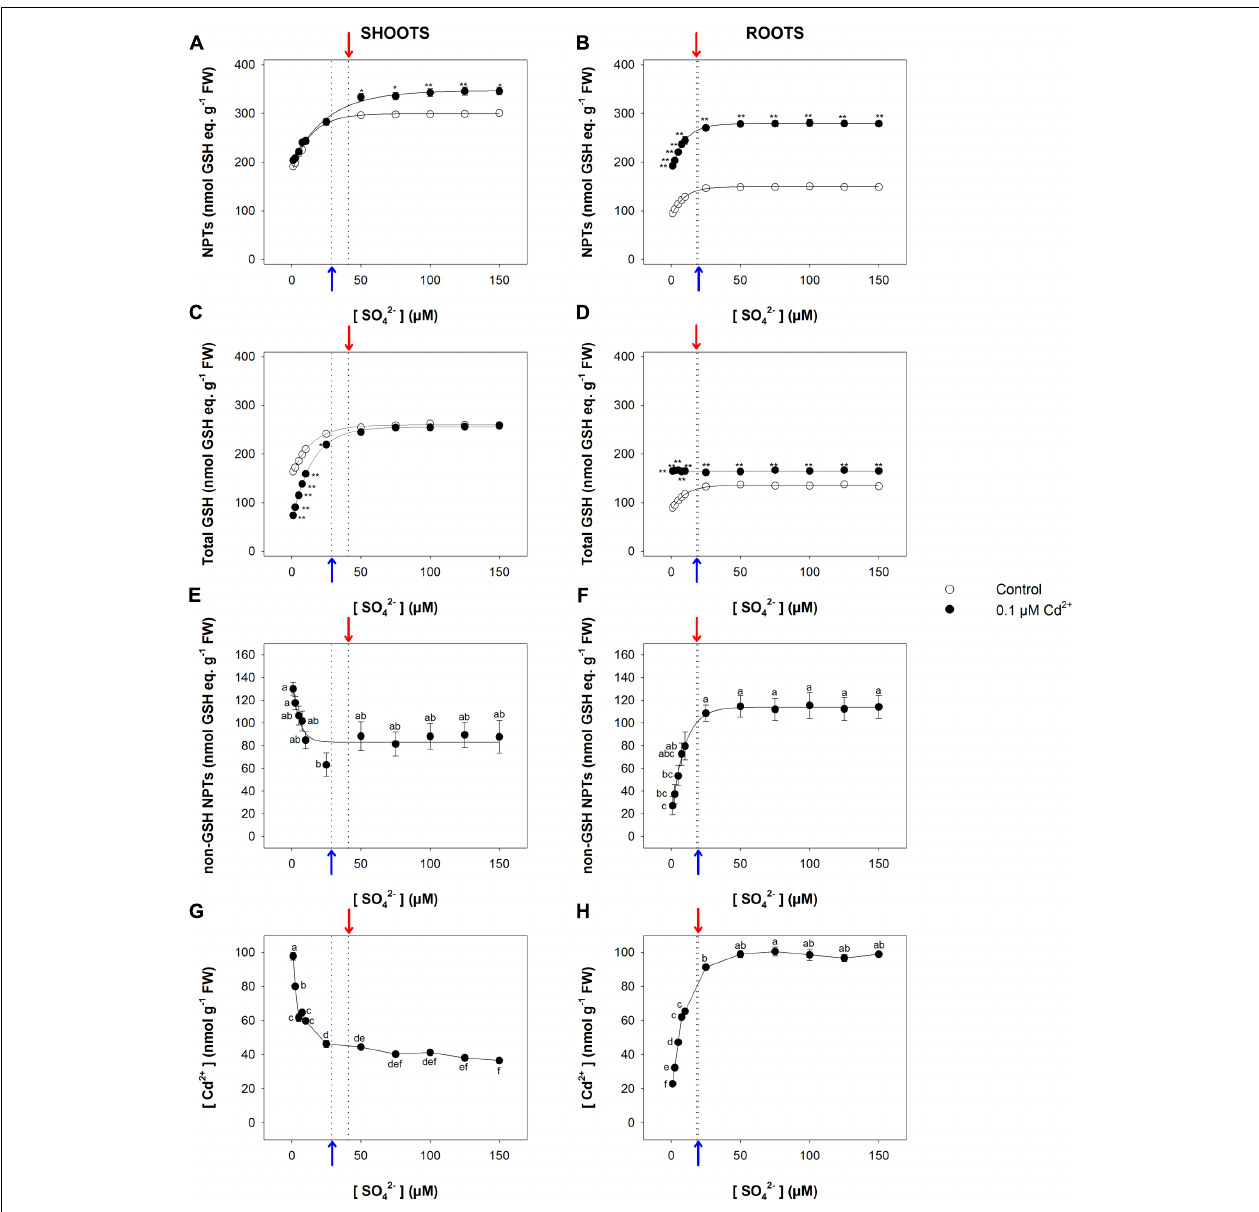
FIGURE 5 | Effect of long-term exposure to Cd on thiol and Cd levels in shoots and roots. Arabidopsis plants were grown for 22 days under a wide range of sulfate concentrations (1, 2.5, 5, 7.5, 10, 25, 50, 75, 100, 125, and 150 µ M) in the presence or absence of 0.1 µ M Cd 2 + . NPT levels in shoots (A) and roots (B) ; total GSH levels in shoot (C) and roots (D) ; PC levels in shoots (E) and roots (F) ; Cd contents in shoots (G) and roots (H) . Data are means and SE of two experiments run in triplicate ( n = 6). Different letters indicate significant differences ( P < 0.05). Asterisks indicate significant differences (Student’s t -test; ∗ 0.001 ≤ P < 0.05; ∗∗ P < 0.001) between control and Cd-exposed plants grown under the same sulfate external concentration. Blue and red arrows indicate the values of [SO 42 − ] crit calculated for control and Cd-exposed plants,